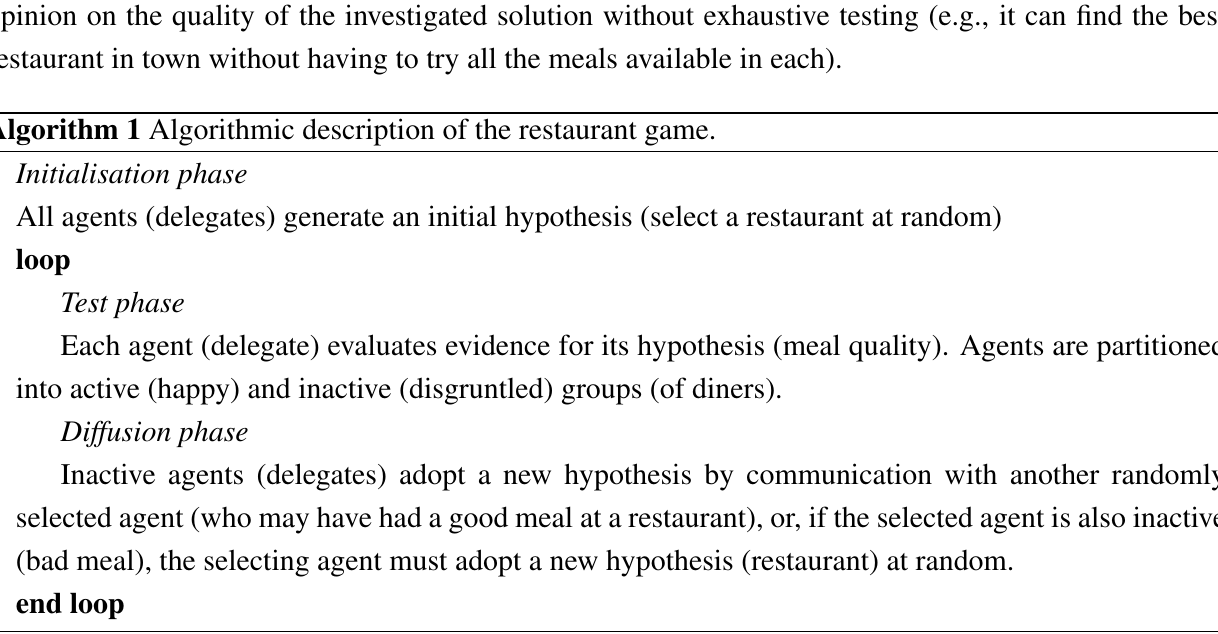
Algorithm 1 Algorithmic description of the restaurant